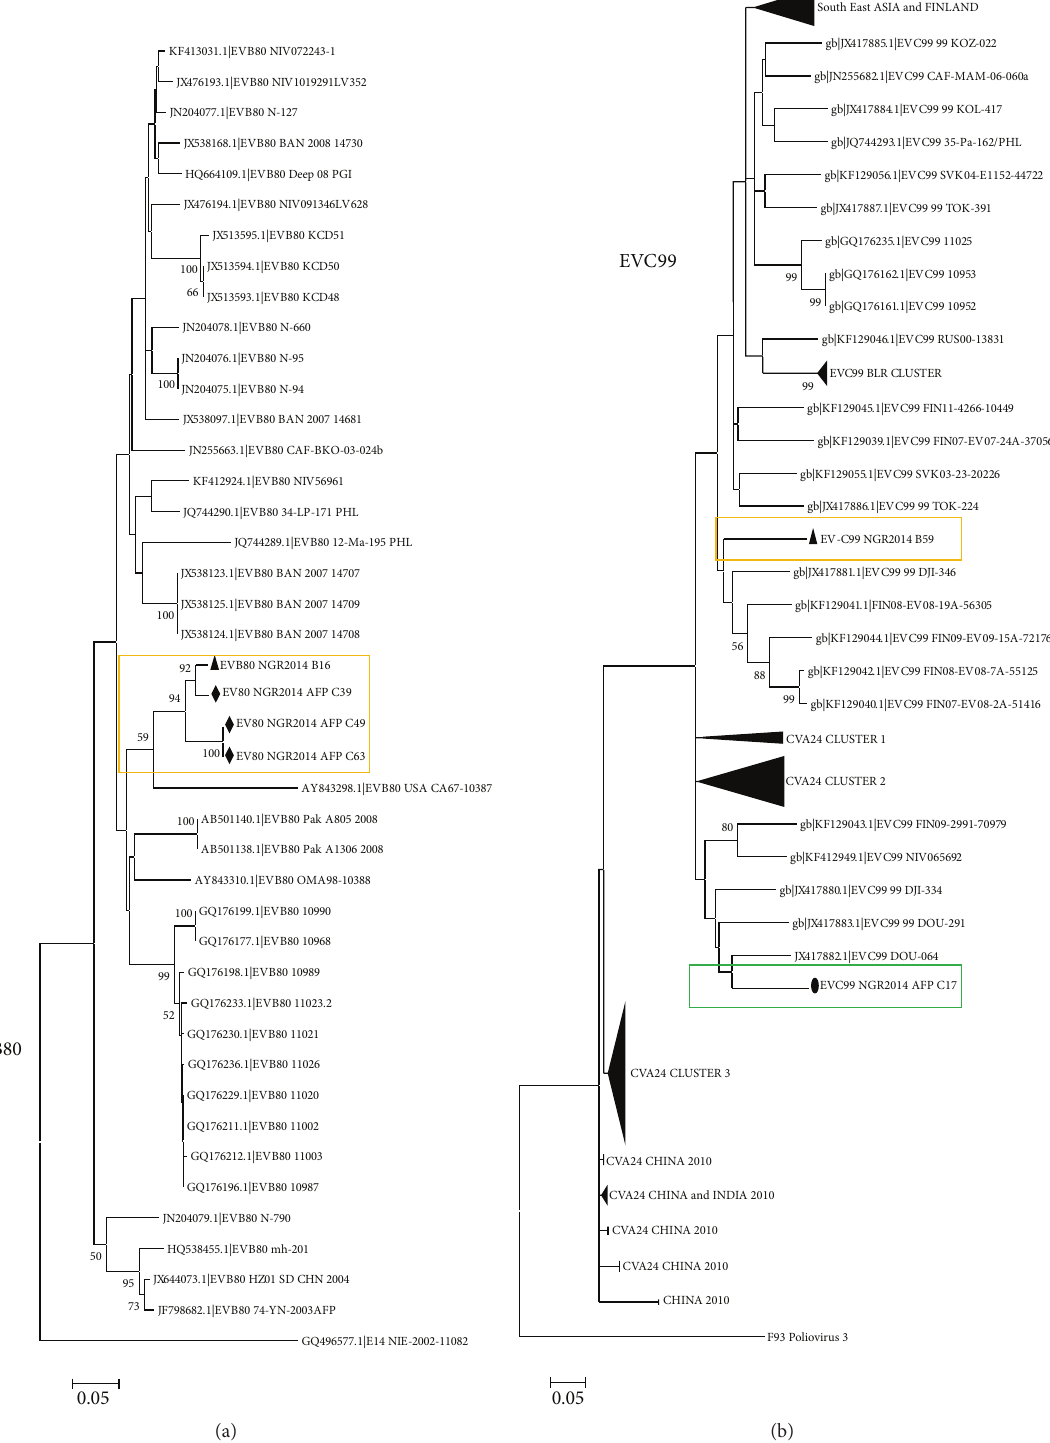
Figure 4: Phylogenetic relationship of recovered EVB80 (a) and EVC99 (b) strains. The phylogram is based on alignment of the partial VP1 sequences. The newly sequenced strains and previous strains from the region are highlighted with black triangles and circles, respectively. The GenBank accession number of the strains is indicated in the phylogram. Bootstrap values are indicated if >